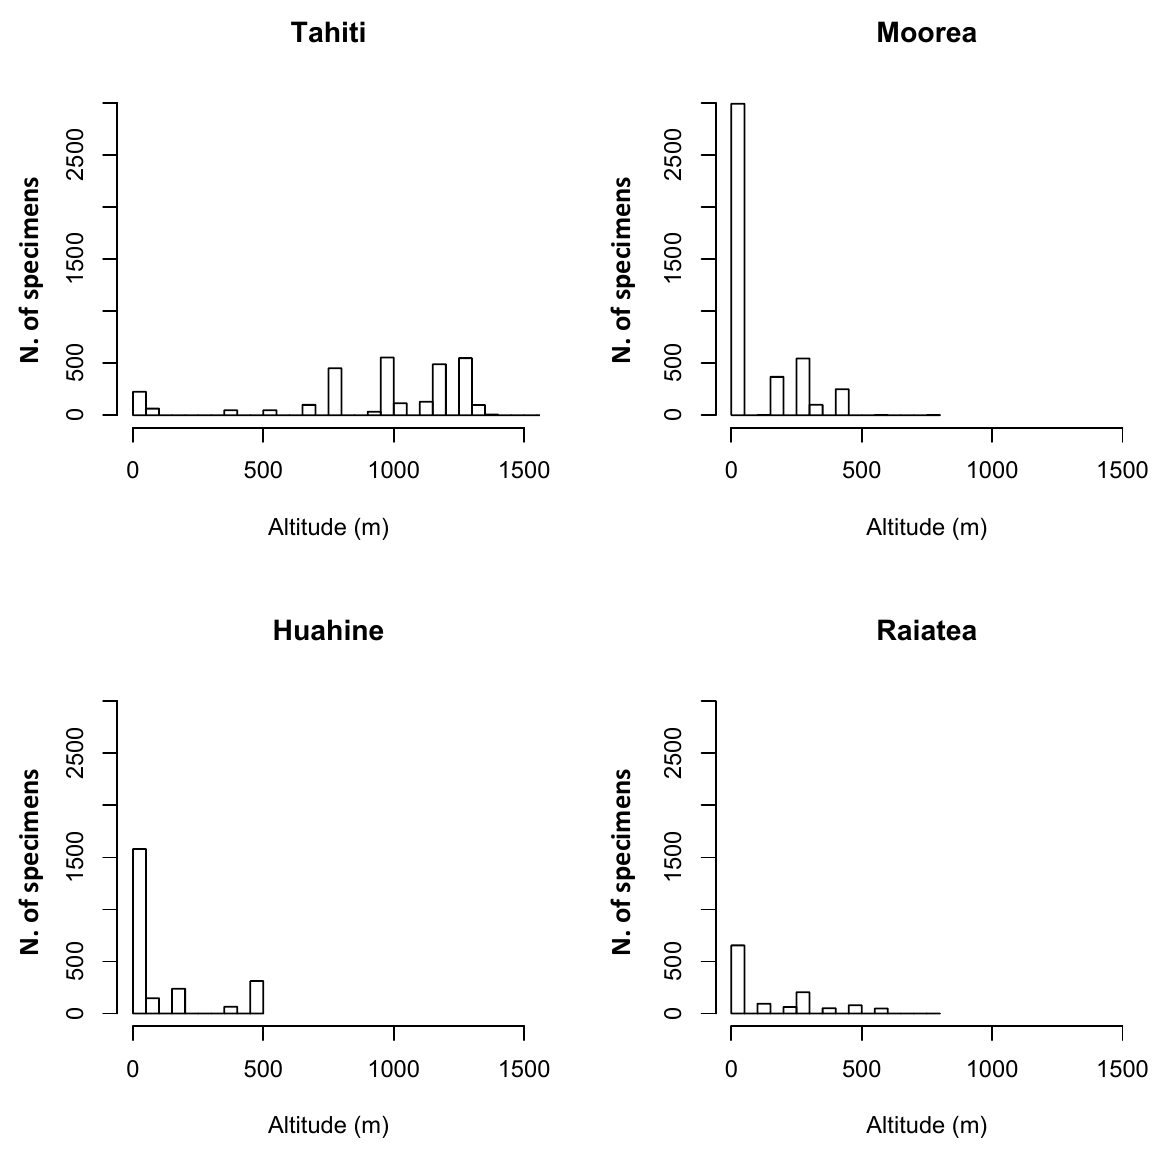
Fig. 1. Distributions of the elevations at which specimens were collected on each island. Figure'1.'